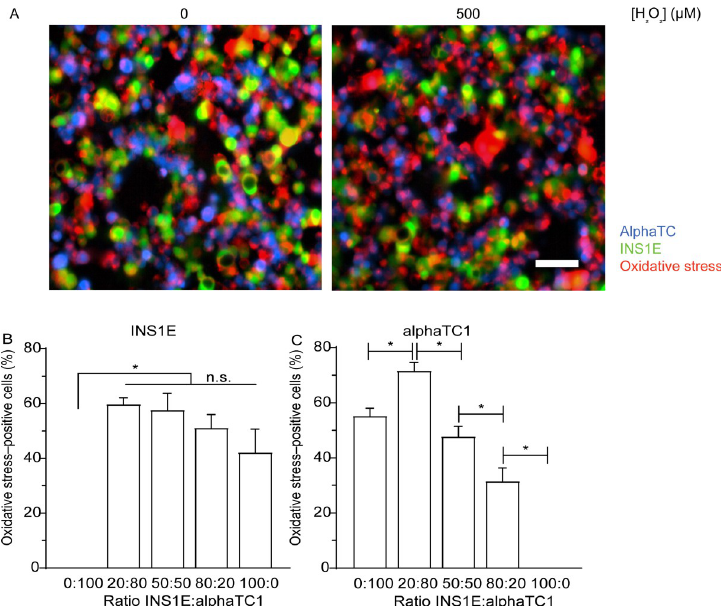
Fig 2. Oxidative stress in INS1E and alphaTC1 cells in monolayer culture. A) H 2 O 2 in a concentration of 500 μ M increased the number of oxidative stress positive (red) INS1E (green) and alphaTC1 (blue) cells. B) Varying the ratio of INS1E and alphaTC1 cells in monolayer culture exposed to 500 μ M H 2 O 2 did not change the percentage of oxidative stress–positive INS1E cells. C) Increasing the percentage of INS1E cells to 80% in a monolayer culture exposed